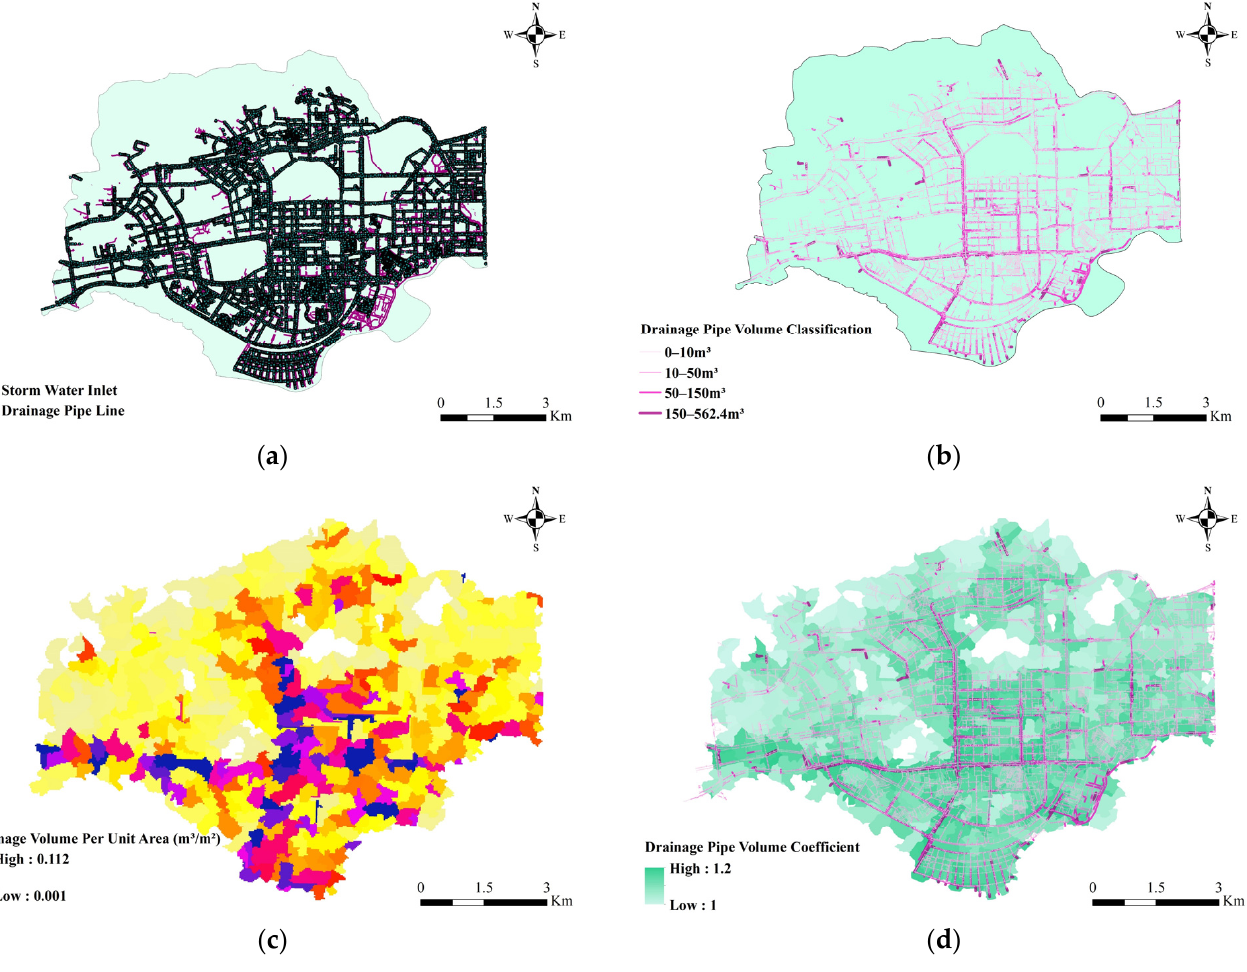
Figure 8. Distribution of drainage system and calculation results of drainage capacity in Futian District. ( a ): Rainwater grate and drainage pipe distribution. ( b ): Drainage pipe volume classification. ( c ): Drainage volume per unit area (m 3 /m 2 ). ( d ): Drainage pipe volume coefficient.